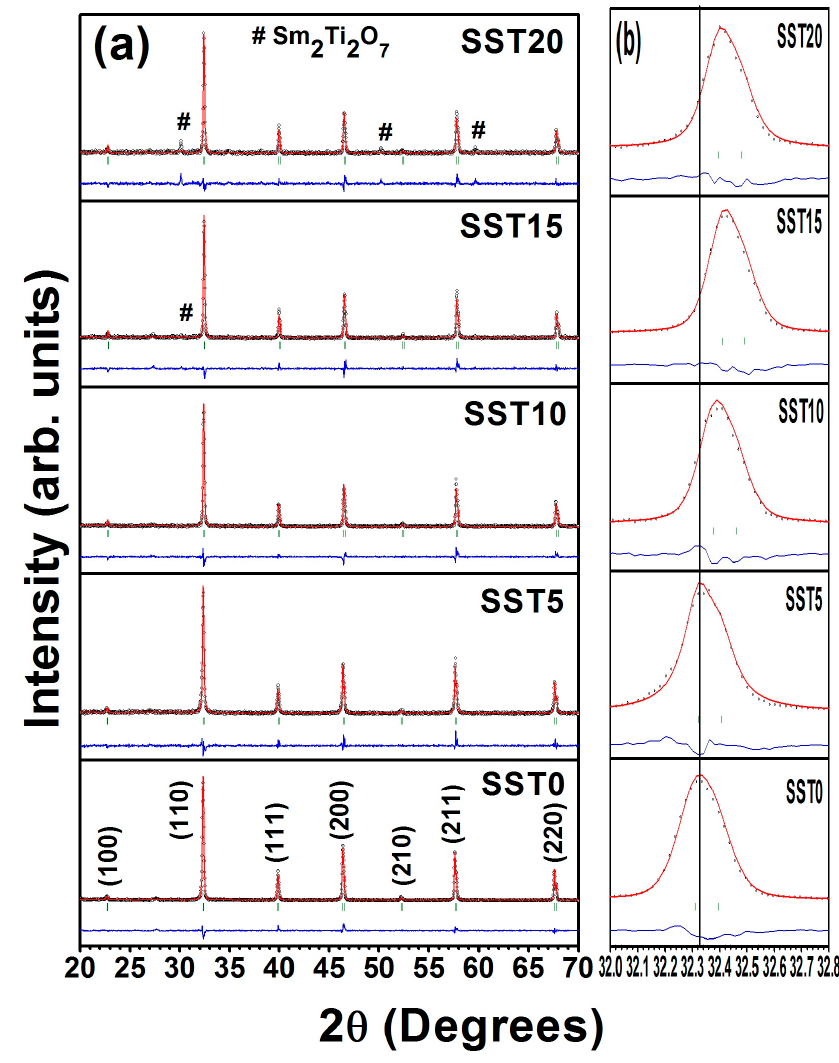
Figure 2. ( a ) The X-ray Rietveld refinement patterns of the sintered samples in air and ( b ) the shifting of XRD diffraction peaks towards higher angle with Sm concentration.